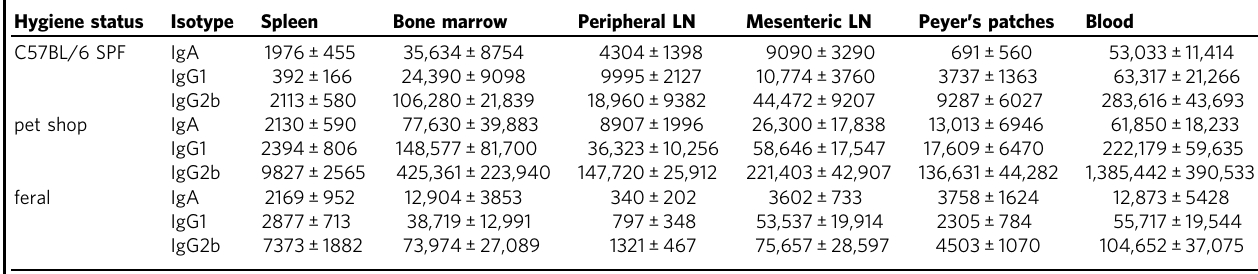
Table 1 Tissue distribution of isotype-switched memory B